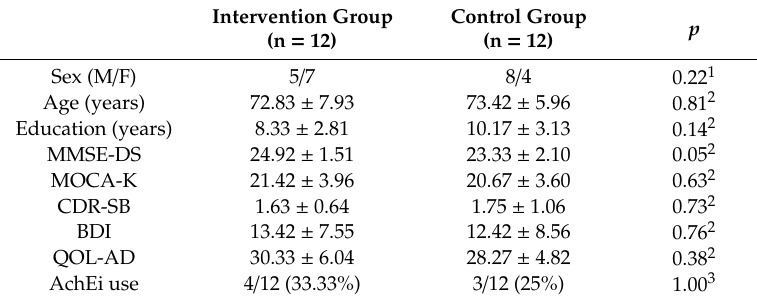
Table 1. Demographic data.